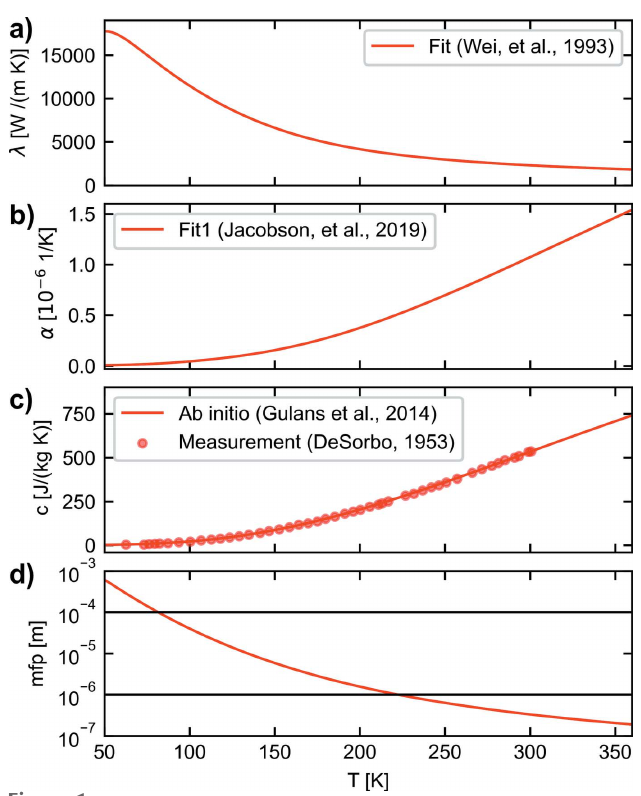
Figure 1 Temperature-dependent material constants of diamond: ( a ) thermal conductivity, ( b ) thermal expansion coefficient, ( c ) specific heat capacity and ( d ) phonon mean free path, where the highlighted values at 1 m m and 100 m m can be considered as characteristic length scales for the simulations carried out in this